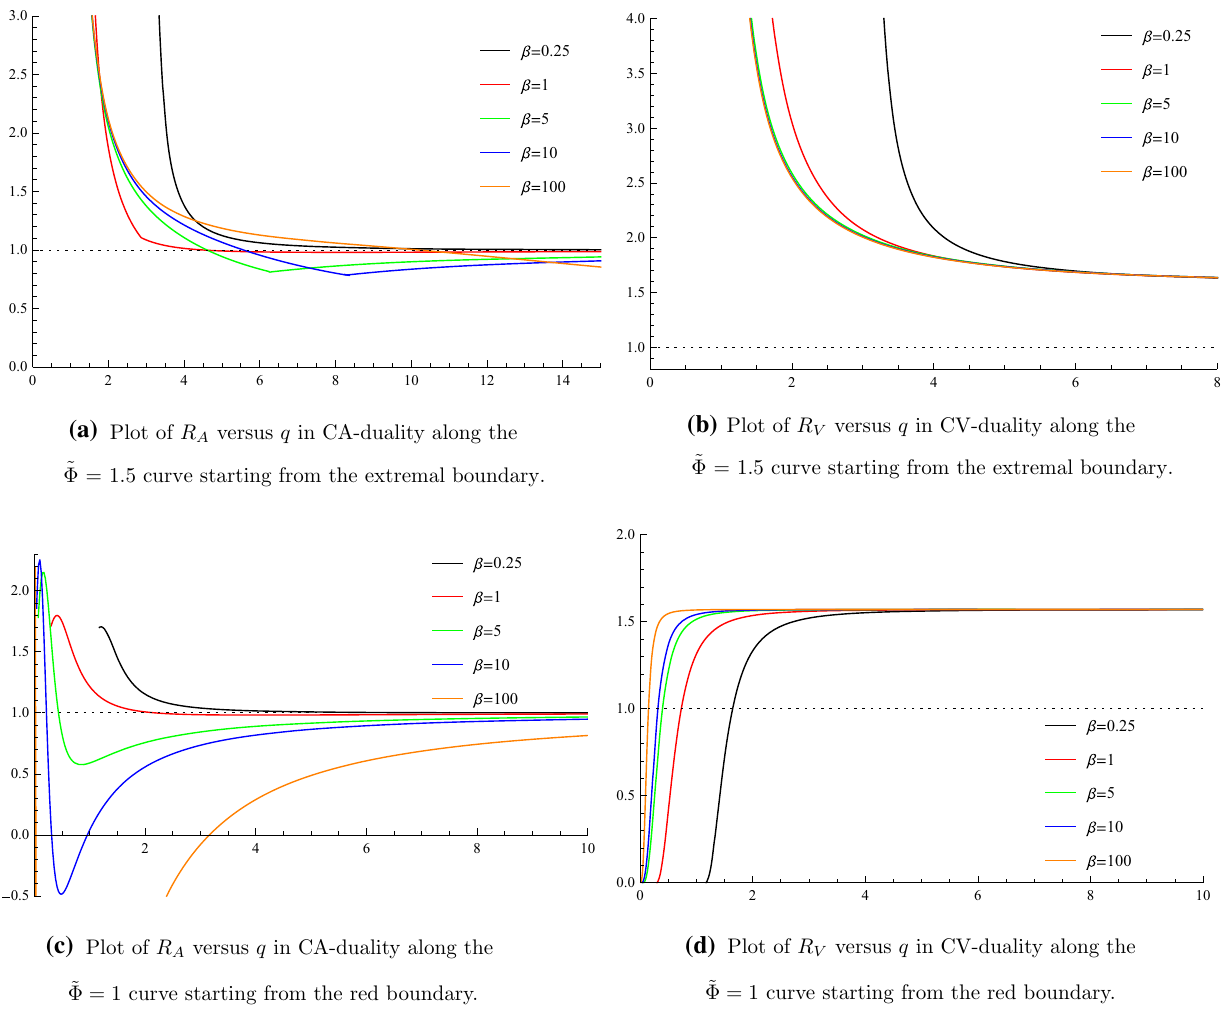
( d ) Plot of R V versus q in CV-duality along the ˜Φ = 1 curve starting from the red boundary.